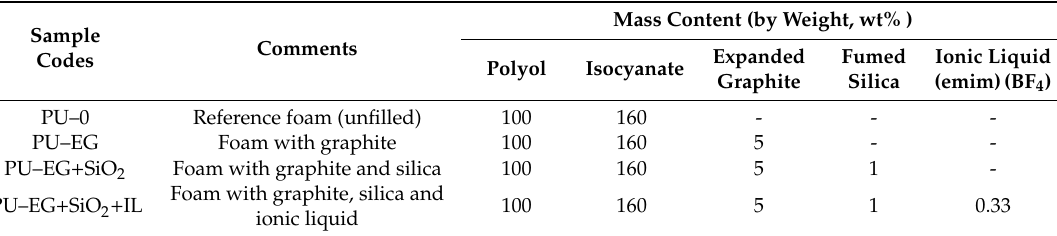
Table 1. Formulations of rigid polyurethane foams (RPUF) prepared in the study.